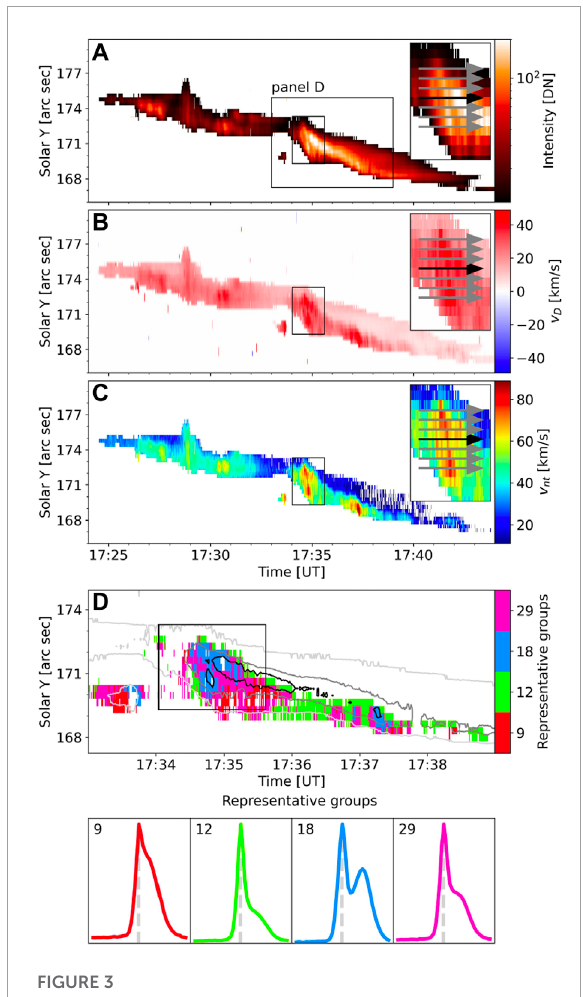
FIGURE 3 Maps of the integrated intensity [panel (A) ], Doppler velocity v D [panel (B) ], and the non-thermal broadening v nt [panel (C) ] of the Si IV 1402.77Å line resulting from the moment analysis. Arrows plotted in the zoomed-in inclusions indicate datapoints examined in Figures 4 , 5 , with the black arrow corresponding to the pixel position 84. Panel (D) details the spatial distribution of Si IV line profiles which exhibited red wing enhancements. The individual pixels, color-coded according to the representative groups to which these profiles belong (displayed in the last row of the figure), are plotted atop of line intensity contours corresponding to 10 (light-grey), 70 (grey), and 140DN